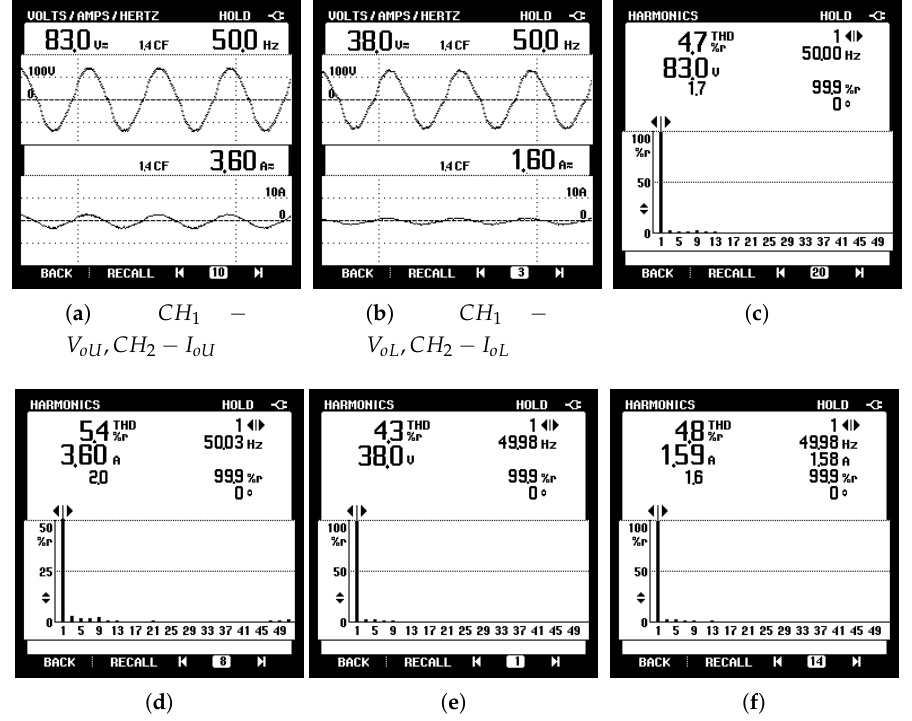
Figure 9. Prototype Results: ( a ) Upper output voltage and load current, ( b ) Lower output voltage and load current, ( c ) Upper output voltage THD, ( d ) Lower output voltage THD, ( e ) Upper Current THD, ( f ) Lower Current